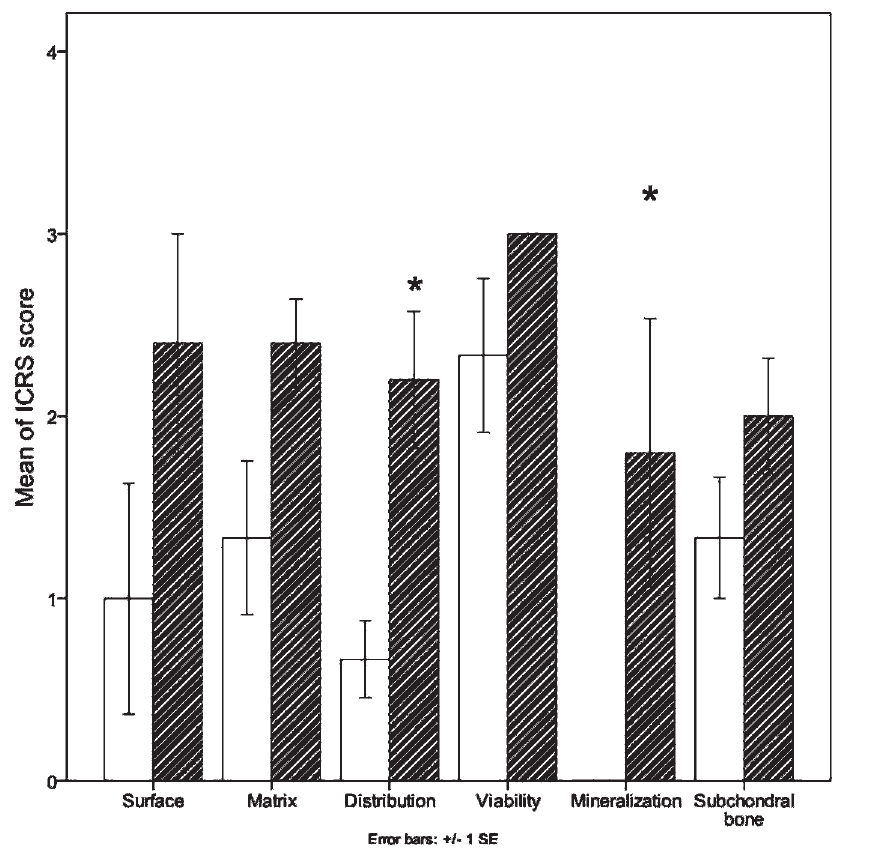
Figure 2 - Bar graph illustrating the International Cartilage Repair Society (ICRS) scores. Significant differences in cell distribution and cartilage mineralization were detected between the experimental group and the control group. * Significant